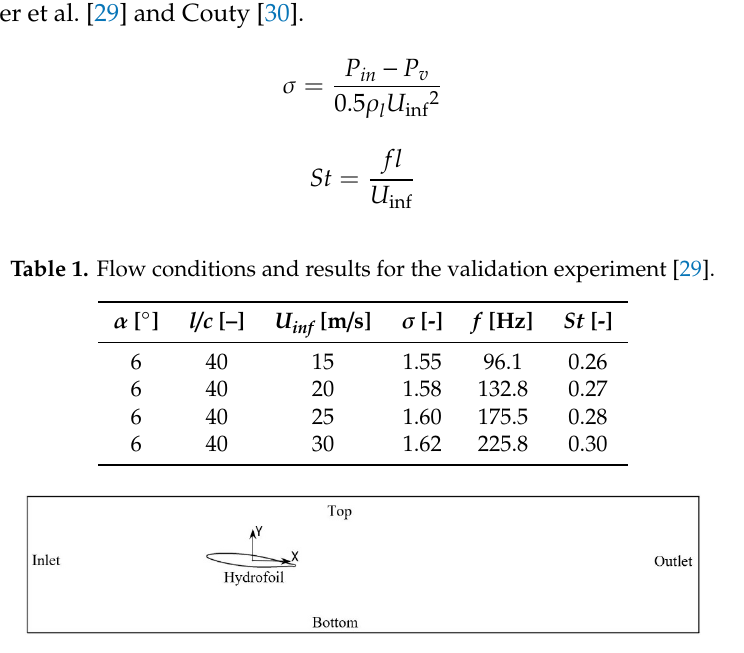
Figure 1. 2D computational domain with named boundaries and frame of reference.